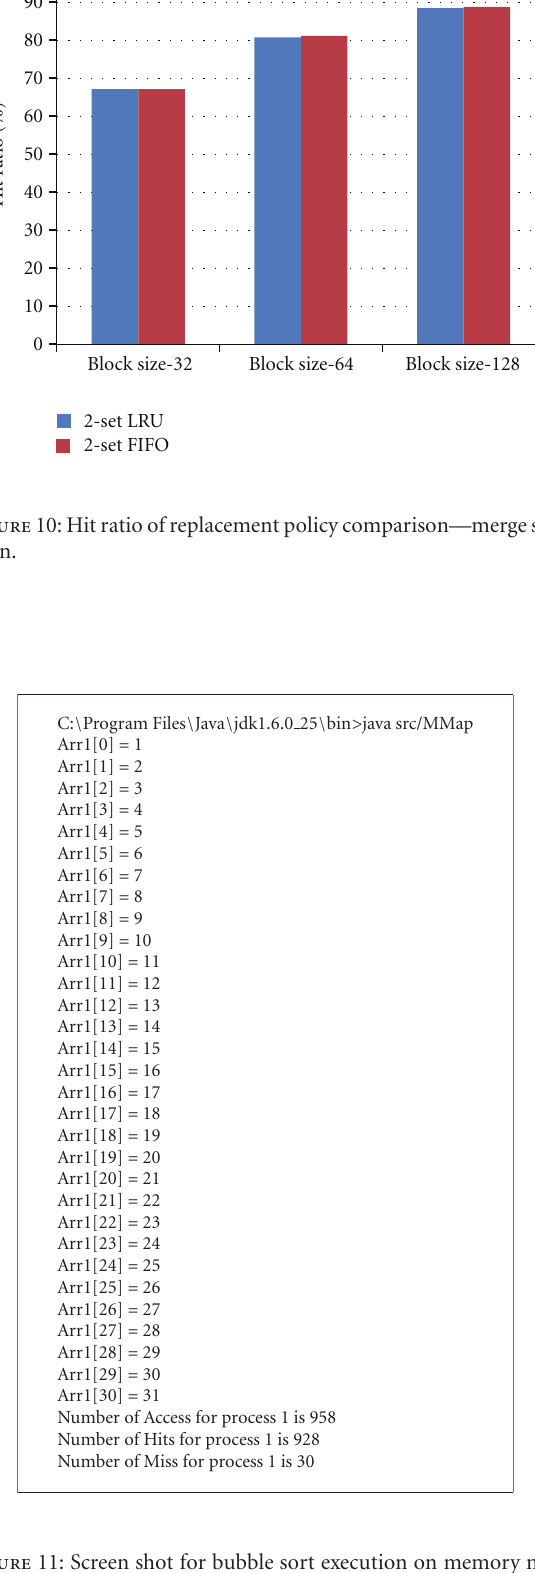
Figure 11: Screen shot for bubble sort execution on memory map simulator with block size of 32 bits.